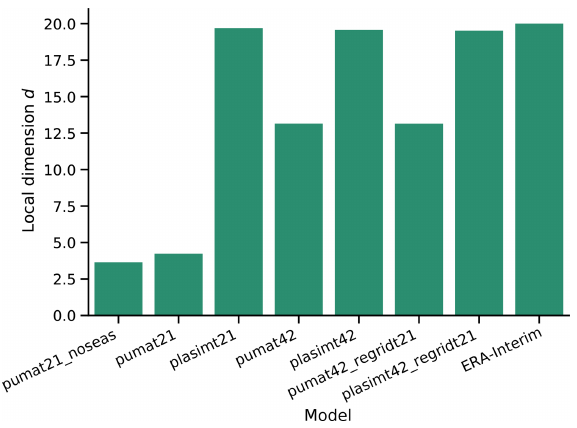
Figure 1. Averages of the local dimension d (here used as a data- based measure of complexity) for the 500hPa geopotential height of the models used in this study and of the ERA-Interim